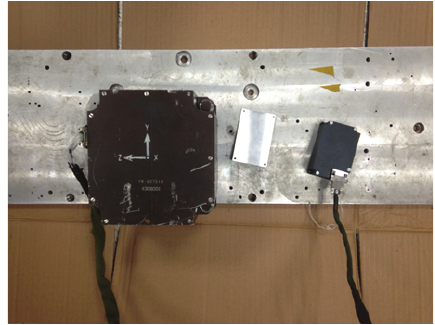
Figure 3: SINS and MINS of the vehicle